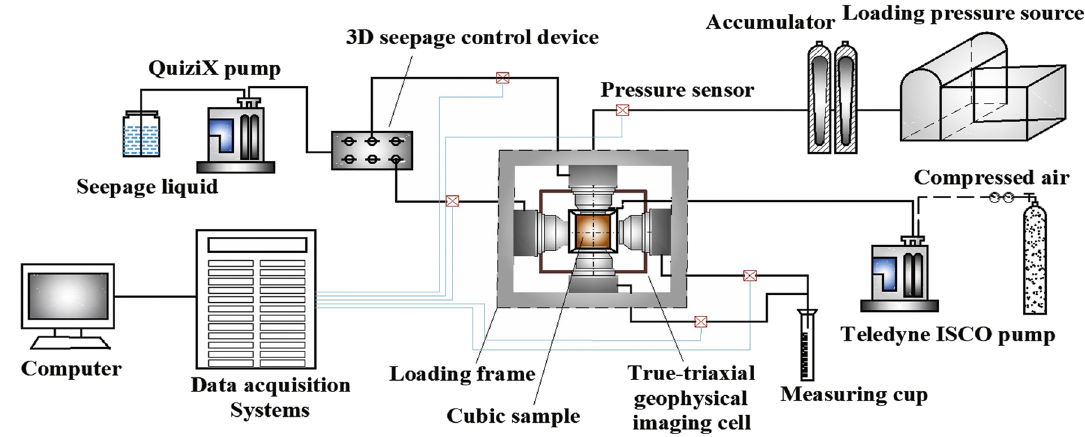
Fig. 6 True triaxial